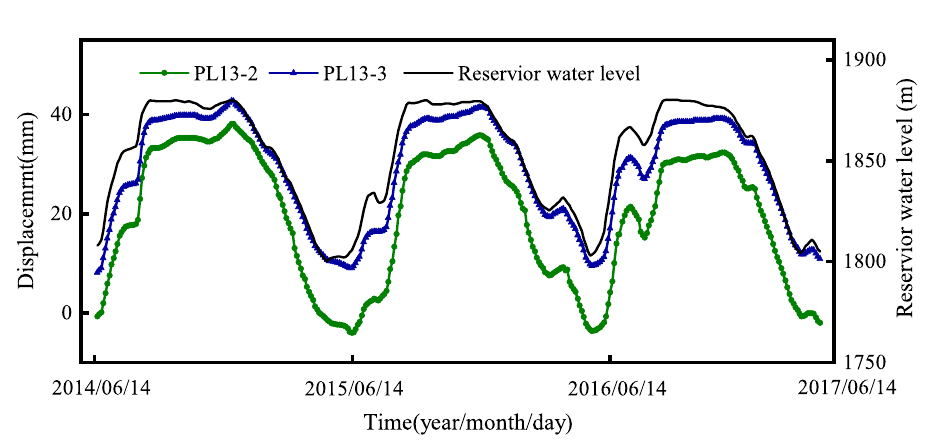
Fig 28. The observed horizontal displacement and water level of the measured points.